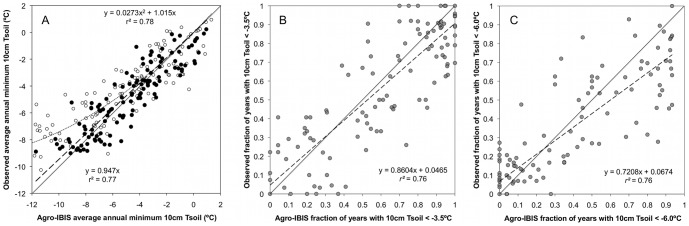
Comparison of observed and simulated annual extreme minimum 10 cm soil temperatures.(a) Agro-IBIS average annual extreme minimum 10 cm soil temperature (based on 3-day running mean temperatures) compared with observations from 125 observation sites (SI, Table S1) from the Midwest USA for original model values (open circles and dotted regression line), and statistically adjusted model values (filled circles and dashed regression line); (b) Agro-IBIS simulated frequency of occurrence of 10 cm soil temperatures (3-day running mean) reaching −3.5°C and (c) −6.0°C, respectively, compared with results from 125 observation sites in the Midwest USA. In these comparisons, Agro-IBIS was only simulated for a period from the beginning year that data was available for each observation station through 2007, which denotes the last year that gridded daily climate data was available.